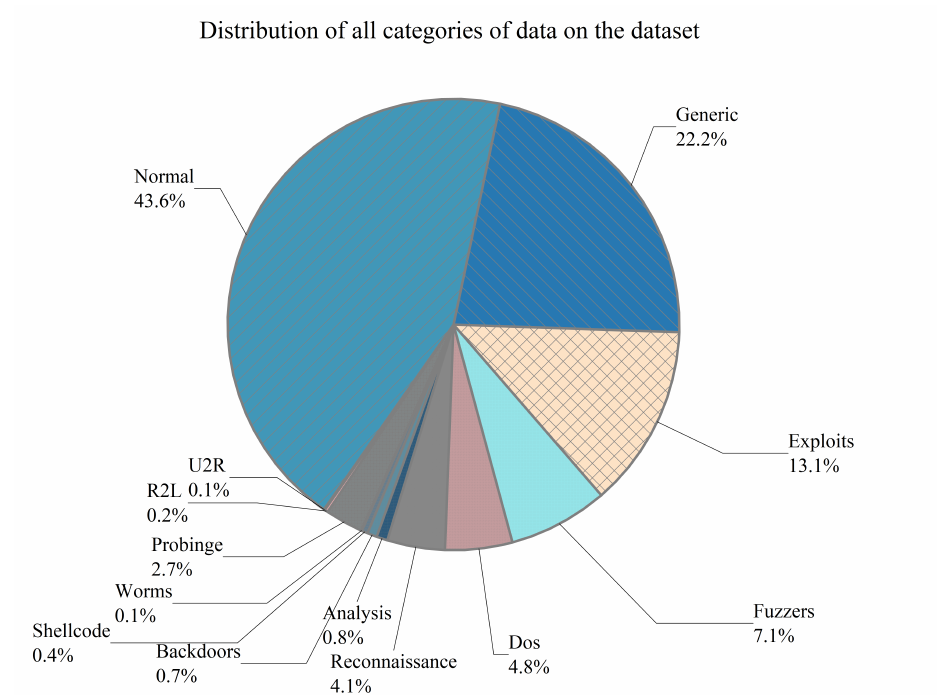
Figure 2. Distribution of all categories of data on the NSL-KDD and UNSW-NB15 datasets.